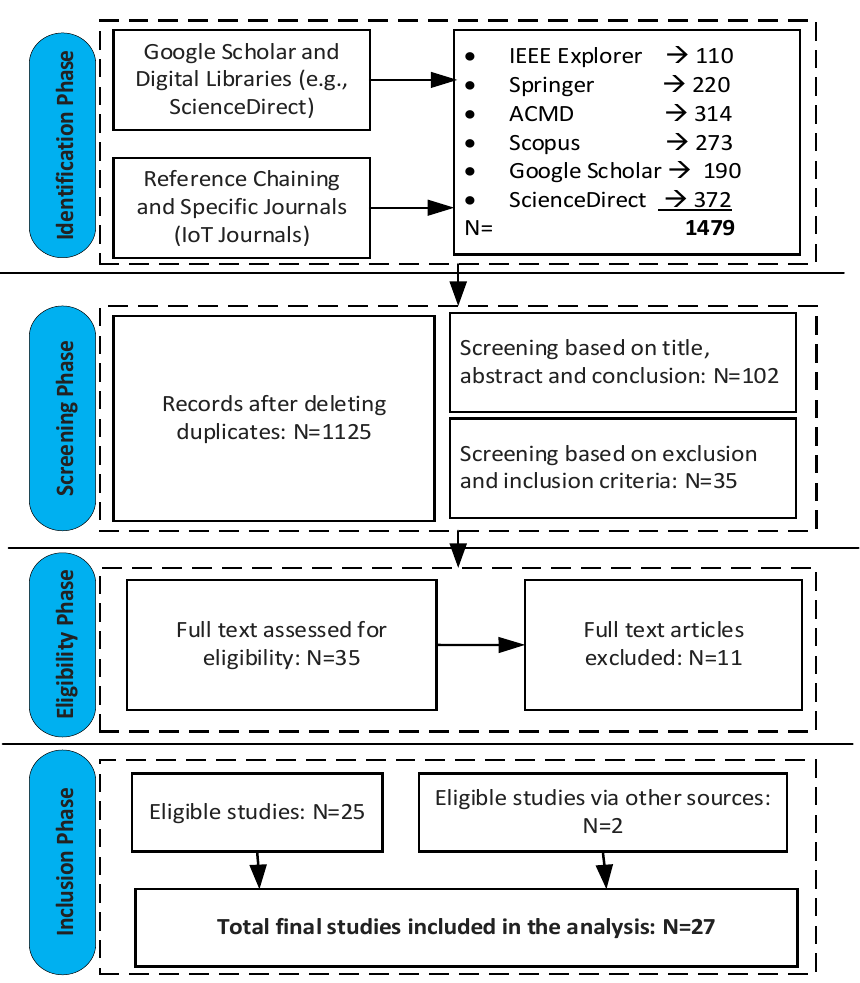
Figure 5. Visualization of the search process flowchart.